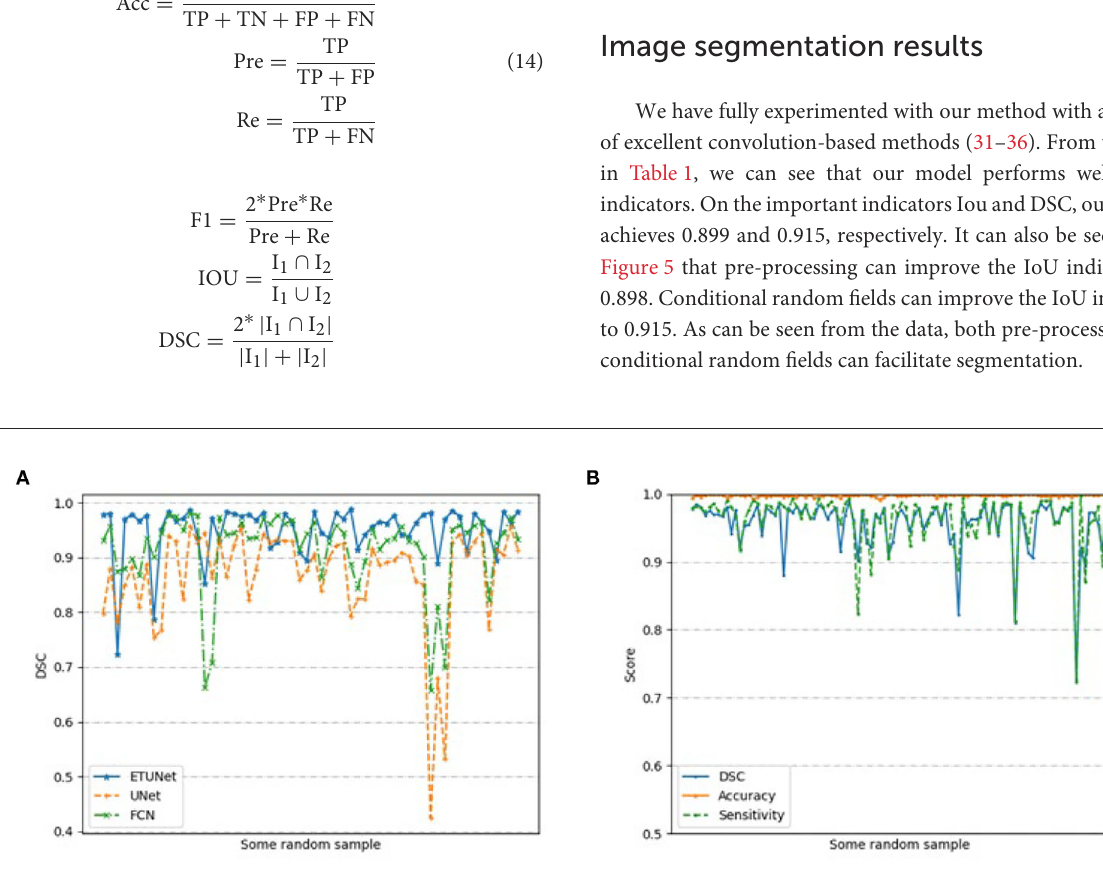
FIGURE7 Performance based on (A) different models on randomly selected samples; and (B) our segmentation model on 200 randomly selected